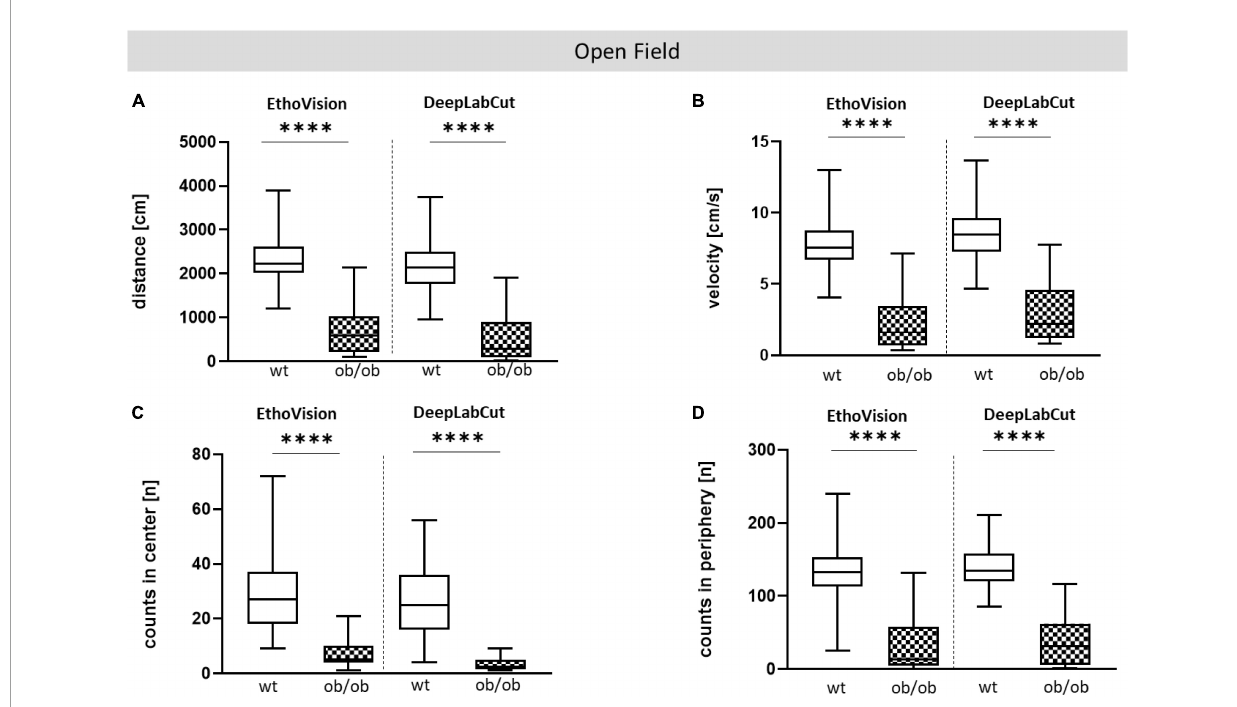
FIGURE5 Comparative analysis with EV and DLC for OF test. OF analysis of wt and ob/ob mice. (A) Moved distance (cm), (B) mean velocity (cm/s), (C) number of visits (counts) in center (n), (D) number of visits (counts) in periphery (n). Significance of differences between the groups were tested by unpaired Student’s t -test. Group size was as follows: n (wt) = 36(EV) or 35(DLC), n (ob/ob) = 40 [EV (A,B,D) ] and 39 (C) or 38 [DLC (A,B,D) ] and 34 (C) . Statistical significance was set at ∗∗∗∗ p < 0.0001. EV, EthoVision; DLC, DeepLabCut.